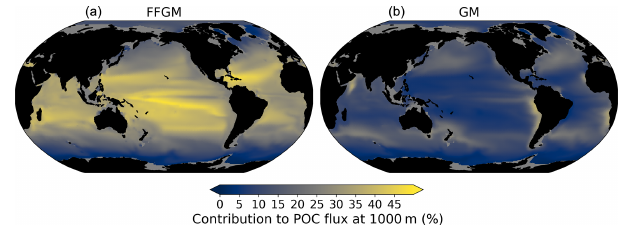
Figure 8. Relative contribution of macrozooplankton to particulate organic carbon flux at 1000m; (a) (resp. right): relative importance at 1000m of FFGM (resp. GM) carcass- and fecal-pellet-driven POC flux to total POC flux (incl. GM and FFGM carcasses and fecal pellets, as well as small and large